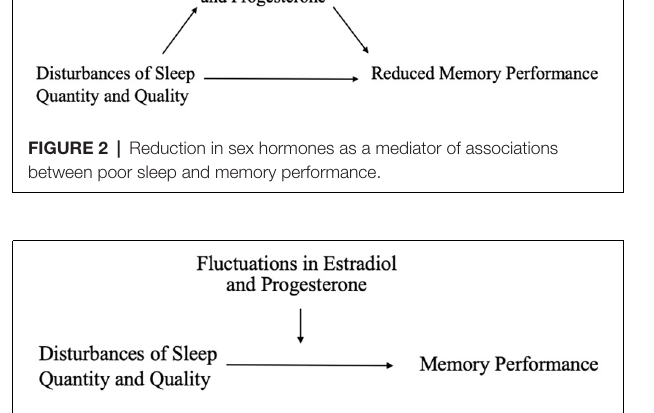
FIGURE 3 | Fluctuations in estradiol and progesterone moderate the relationship between sleep and memory